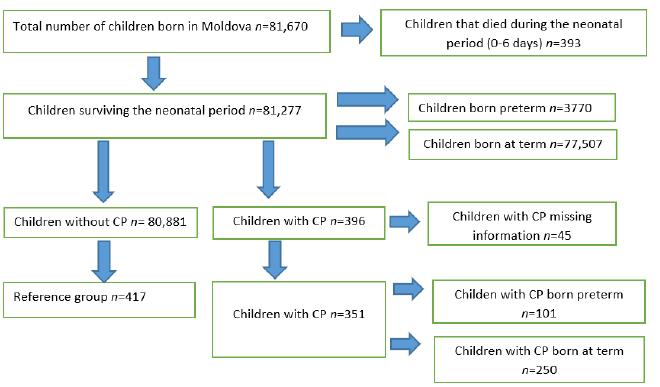
Figure 1. Study population: Children with cerebral palsy (CP) and children without cerebral palsy 2009 and 2010 in Moldova).